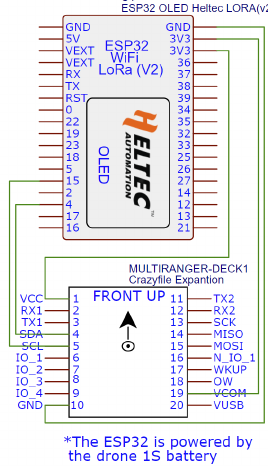
Figure A1. Wiring Diagram. The sensor has 5 pins: PWR, GND, SDA, SCL, and XSHUT. The XSHUT pin can be used to hold the sensor in standby mode, useful for setting up multiple